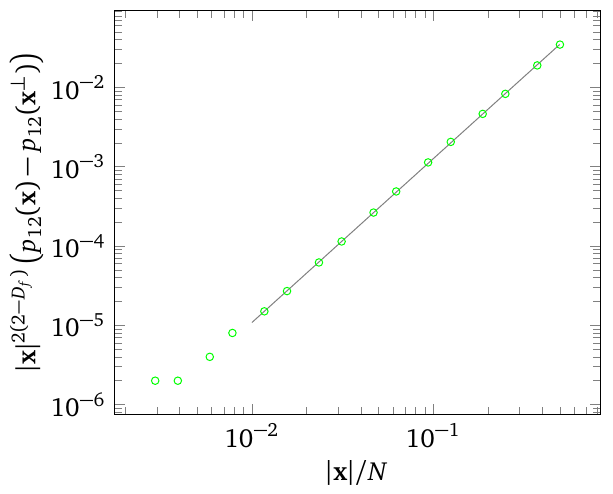
Figure 10: Difference of connectivities (28) for H = − 2 / 3, measured for M / N = 2, N = 2 11 and θ = 0. The best fit line has slope ∼ 2.07, indicating the presence of the stress-energy tensor.